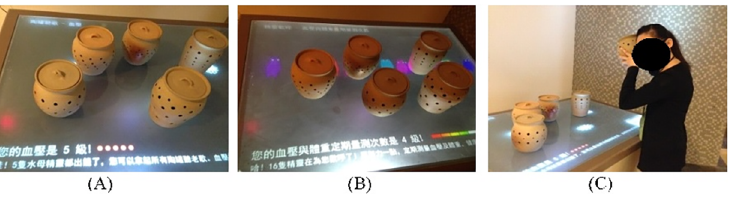
Fig 4. Interactive Table with Musical Pots. (A–B) After RFID identity authentication, the user is presented with a summary of their metabolic condition (C) If the medical indicator shows normal, the song within the corresponding pot plays once it is brought up to the